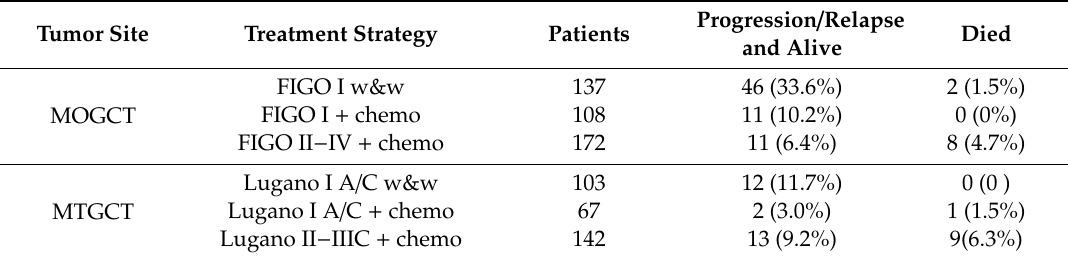
Table 1. Events in patients with localized and advanced malignant germ cell tumors (MGCT) in respect to stage and treatment strategy. MOGCT: malignant ovarian germ cell tumors, MTGCT: malignant testicular germ cell tumors.